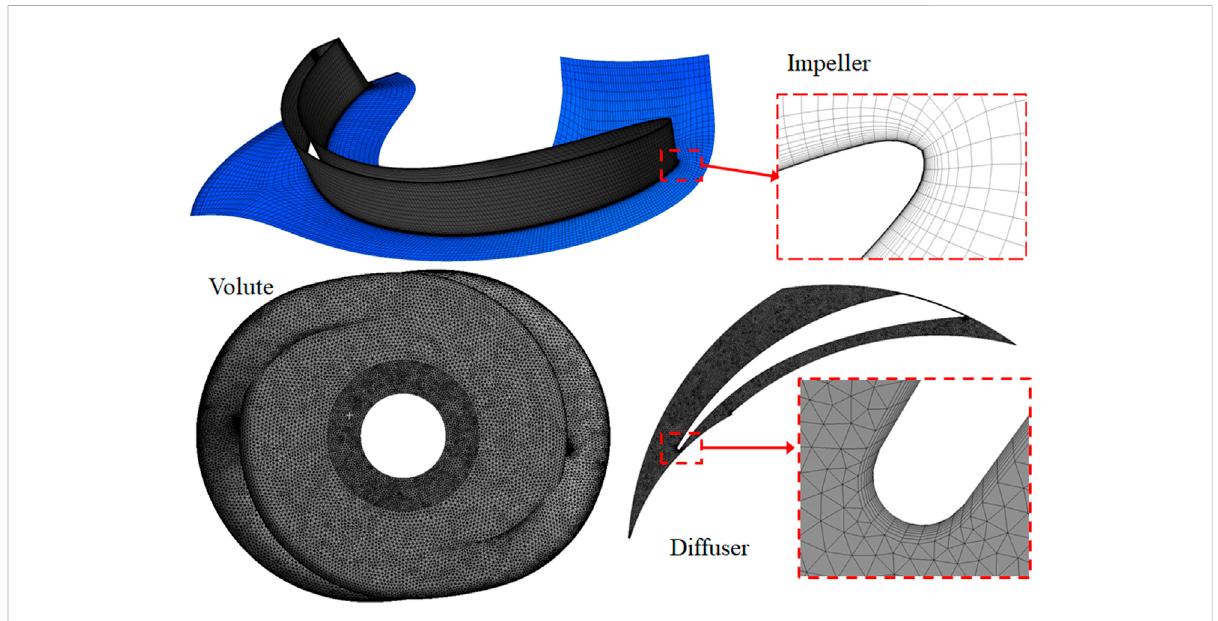
FIGURE 3 Optimal grid of the impeller, volute and